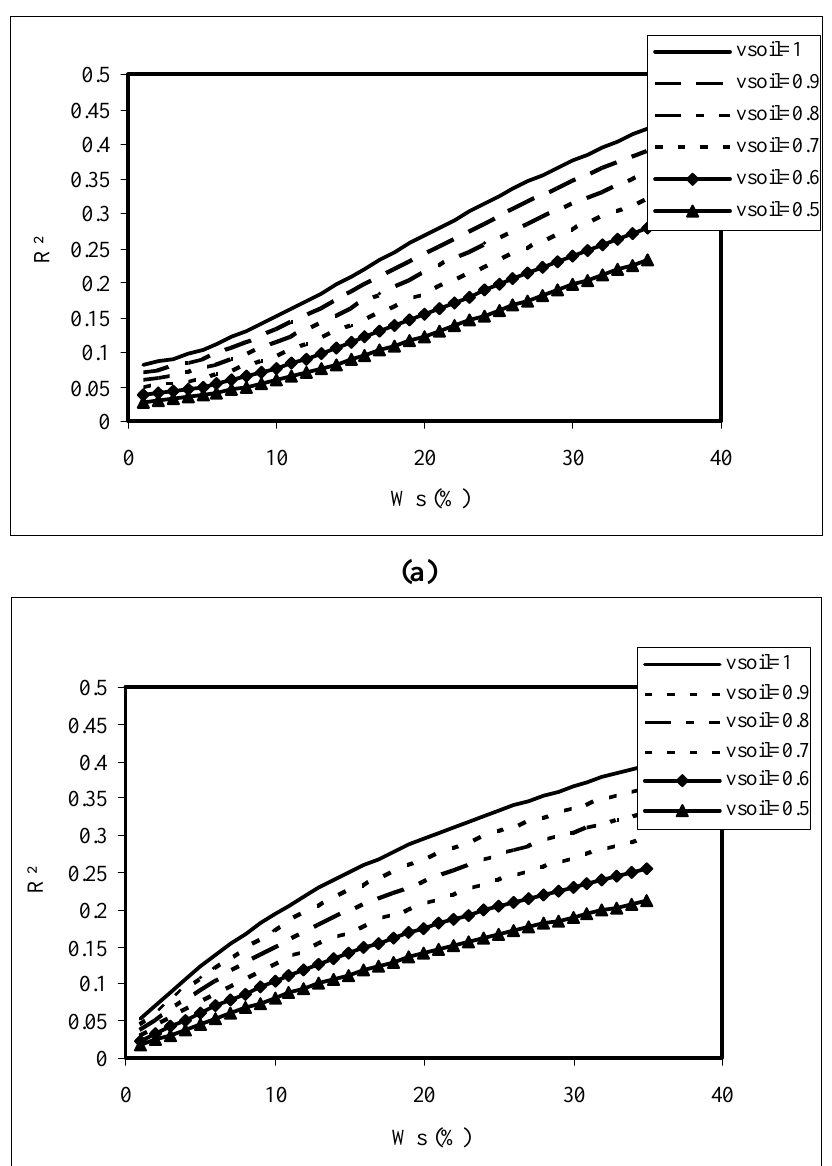
Figure 6 . Illustration of variations in 2 R , as a function of soil moisture, for different values of the  (1.25 GHz), (b) at C band (5.3